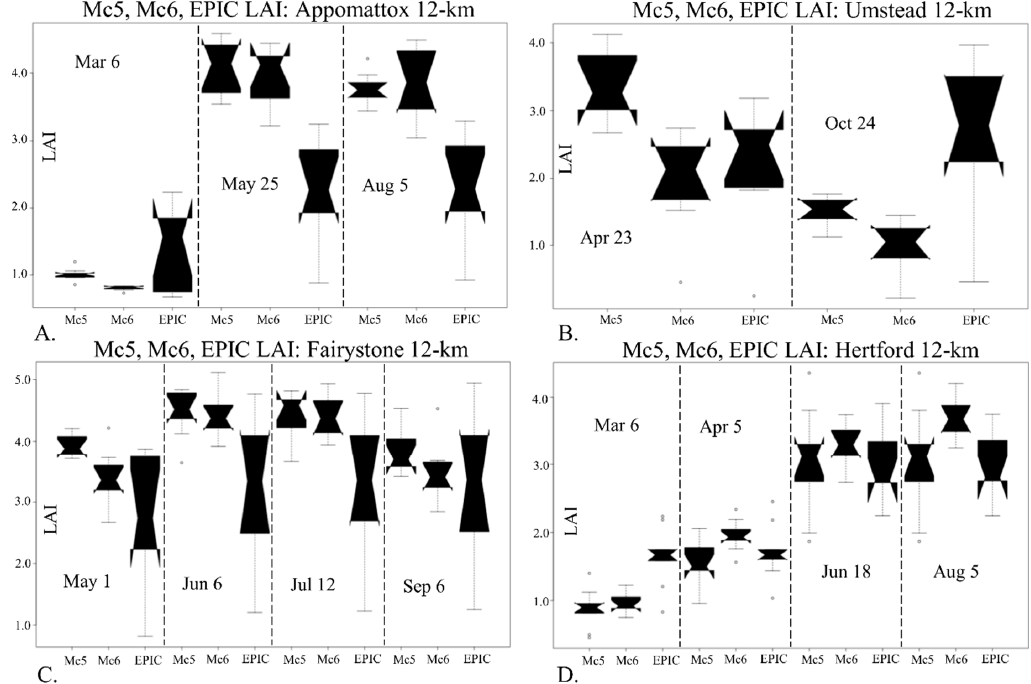
Figure 8. Notched box whisker plots of MODIS (Mc5 and Mc6) comparisons to Environmental Policy Integrated Climate (EPIC) modeled LAI across Appomattox ( A ), Umstead ( B ), Fairystone ( C ), and Hertford ( D ) across 13 dates. The box represents the interquartile range (50% of data) bracketed by the whiskers (99.3% of data). The notch displays the 95% confidence interval around the median (horizontal line). The small circles above/below the whiskers identify possible outliers. Overlapping notches suggest ‘strong evidence’ that medians differ). Note: Notched boxplots created through: Wessa P., (2017), Notched Boxplots (v1.0.10) in Free Statistics Software (v1.2.1), Office for Research Development and Education, URL http://www.wessa.net/rwasp_notchedbox1.wasp/ [46]. Table 9. Mean EPIC and MODIS (Mc5 and Mc6) LAI comparisons at 12.0 km scale within 3 × 3 grid ( n = nine 12 km grid cells per date).